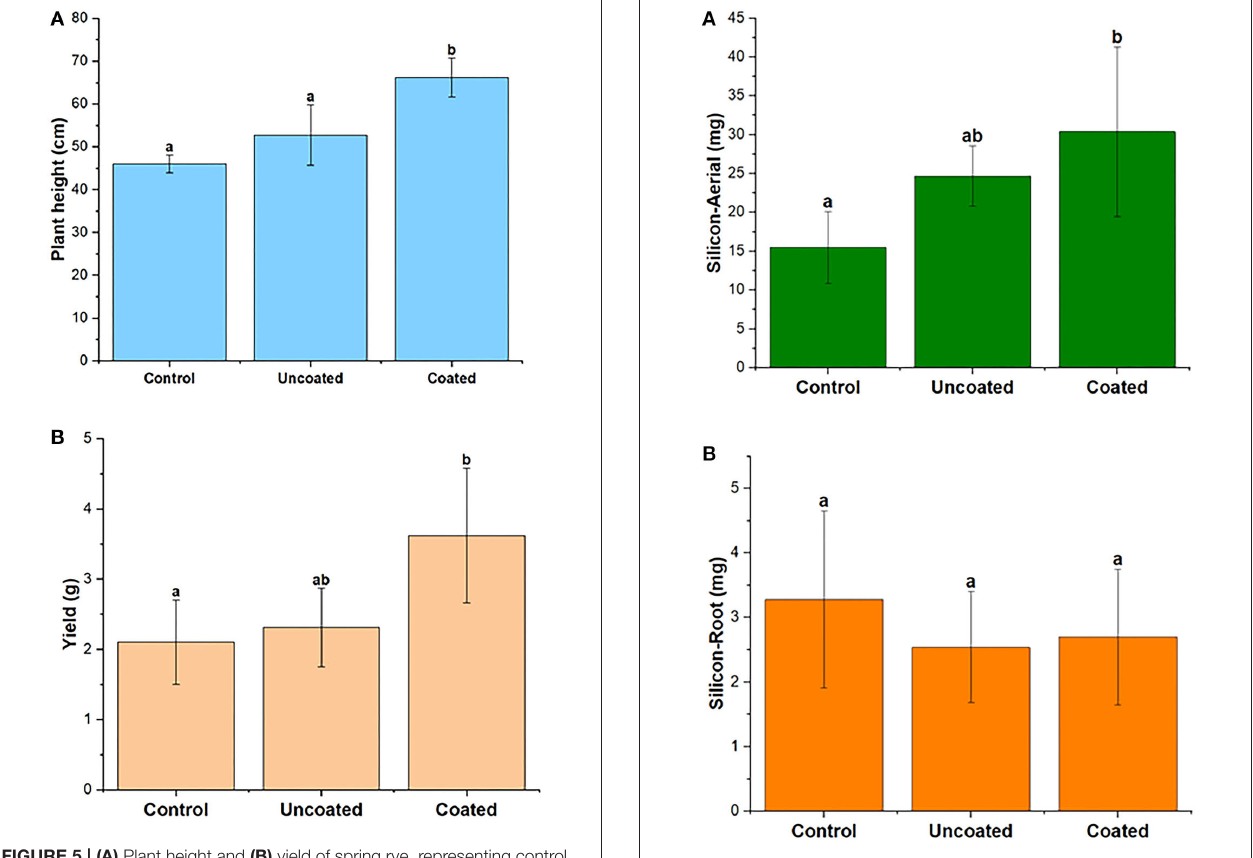
FIGURE 6 | Total silicon of (A) aerial and (B) root biomass of spring rye (per plant), representing control, uncoated, and coated treatments. Lowercase letters (a–e) indicate significant differences between treatments ( p <